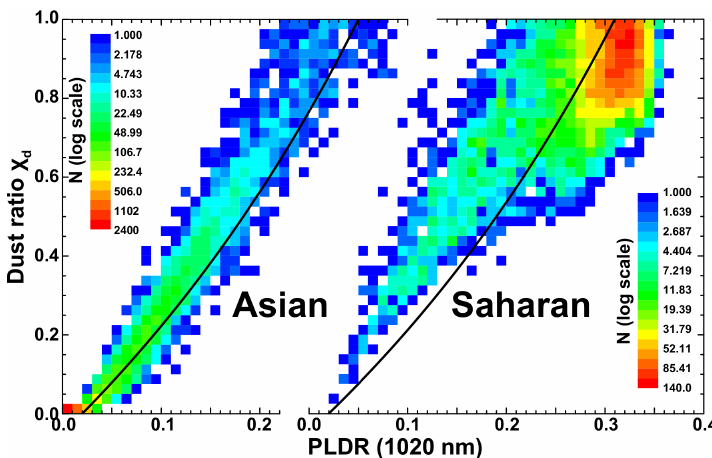
Figure 5. Two-dimensional histograms of 1020nm PLDR and χ d for the considered AERONET stations affected by Asian (a) and Saharan dust (b) . The black lines refer to the backscatter-related dust ratio R d .